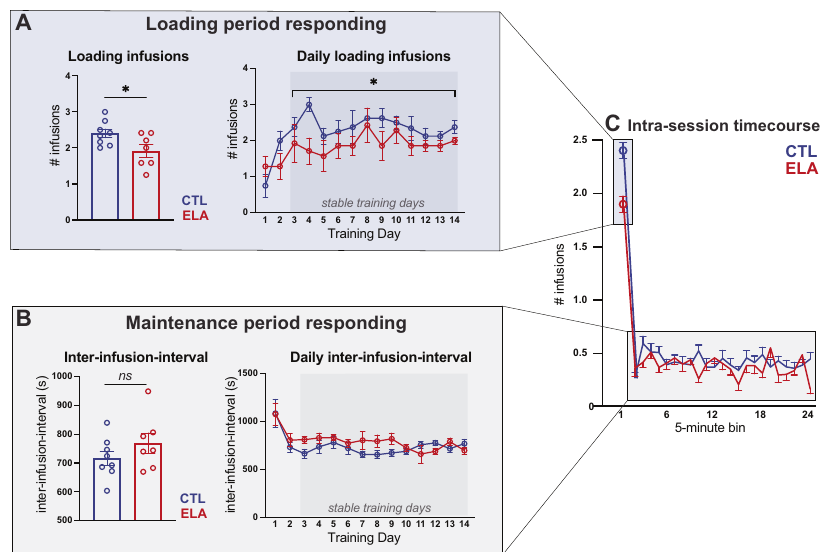
Fig. 3 ELA speci fi cally blunts loading phase heroin consumption. A ELA rats consumed fewer infusions during the fi rst 5 min “ loading period ” of the 2 h session across stable training days (days 3 – 14). B Average inter-infusion-interval was not different between ELA and CTL, but there was a signi fi cant ELA x training day interaction on stable training days (days 3 – 14). C Average consumption across the 2 h session. * ELA vs CTL P < 0.05. n = 8 CTL/7